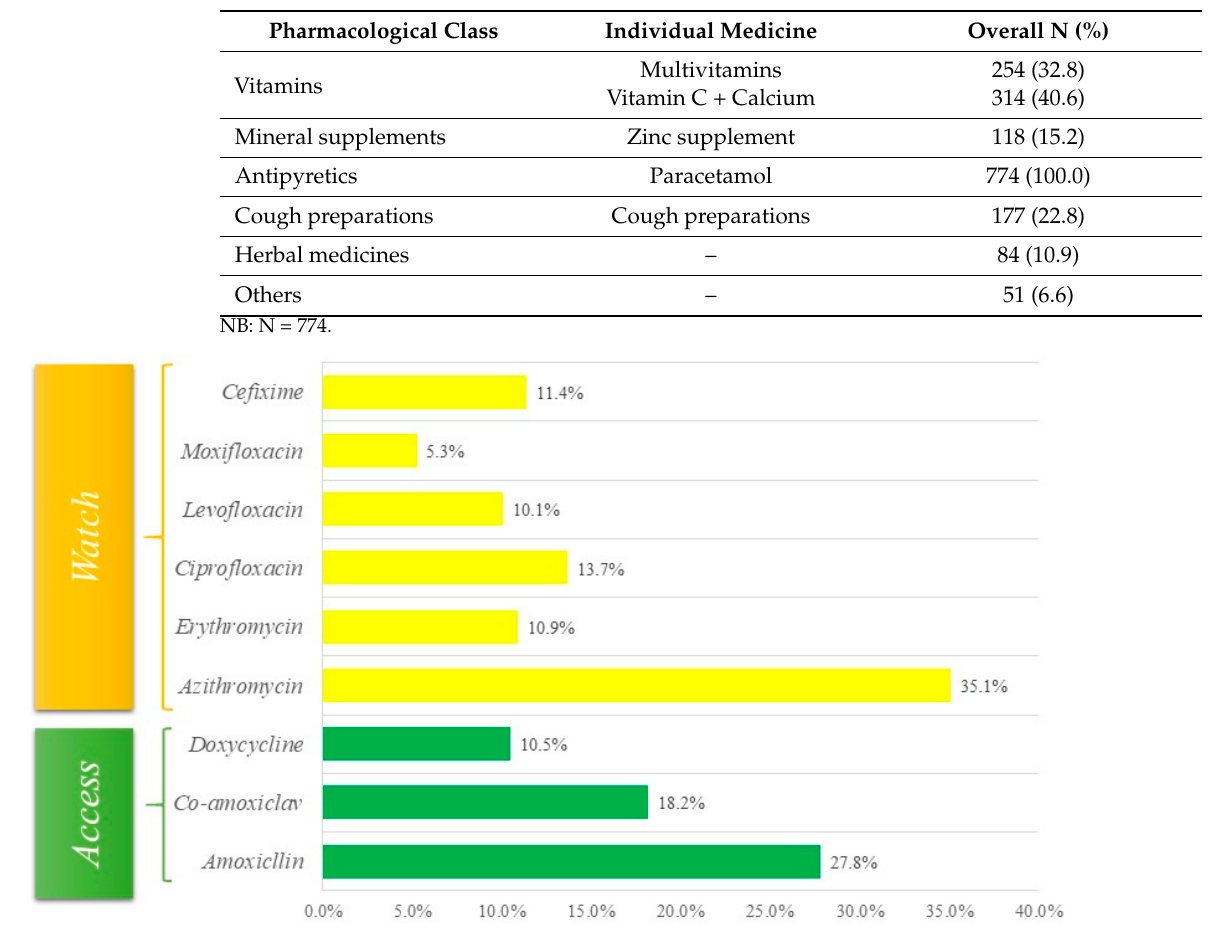
Figure 4. Details of antibiotics purchased by AWaRe classification. NB: “access” and “watch” antibiotics taken from the WHO AWaRe list, see Methods.